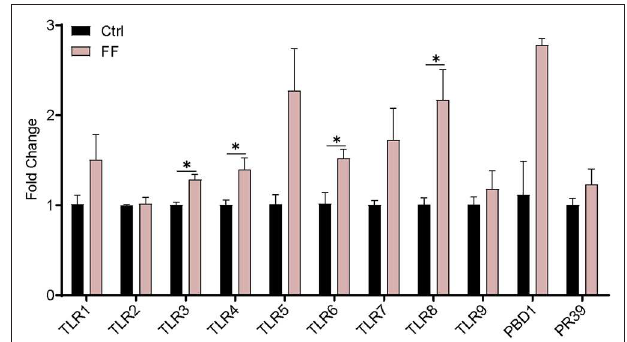
FIGURE 2 | Effect of FF on the expression of genes related to blood immunity. The Ctrl group was designed as 1-fold change. Ctrl, pigs fed with normal commercial feed; FF, pigs fed with fermented meal. Data are presented as mean ± SEM ( n = 6). * P <